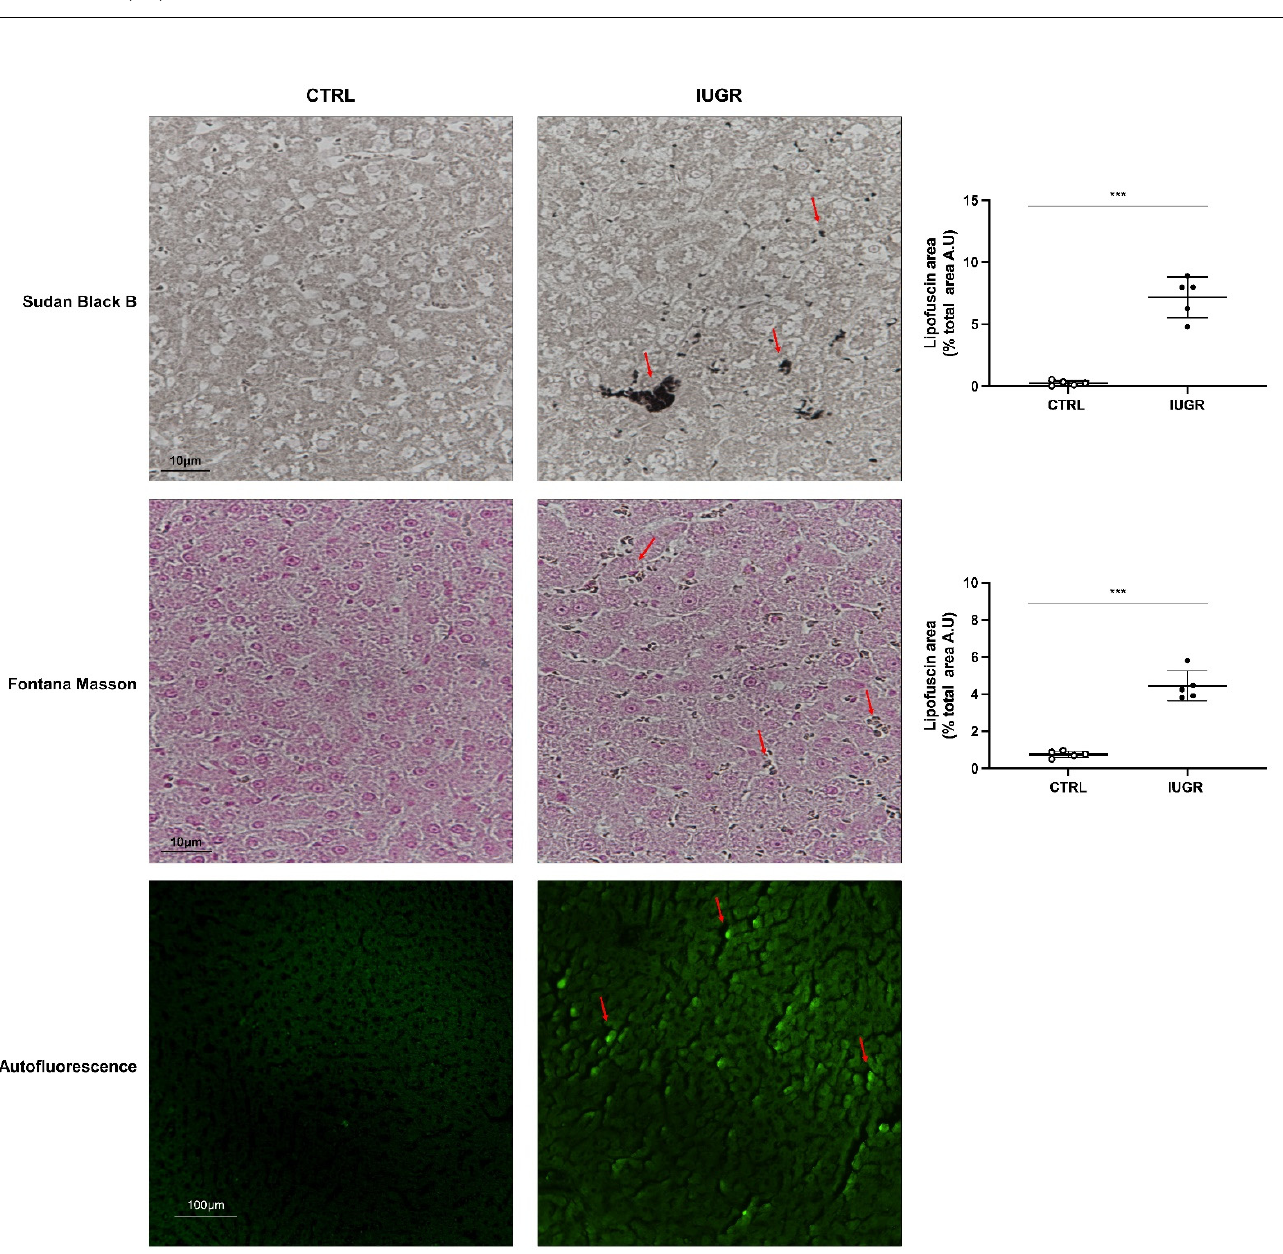
Figure 10. Lipofuscin detection in CTRL and IUGR male livers at 6 months of age. Lipofuscin detection was performed using SBB and Fontana Masson staining and with autofluorescence. Lipofuscin deposits are indicated by arrows. n = 5 animals/group. *** p < 0.001. Magnification (20 and 40×). Scale bar = 10 and 100 µm.